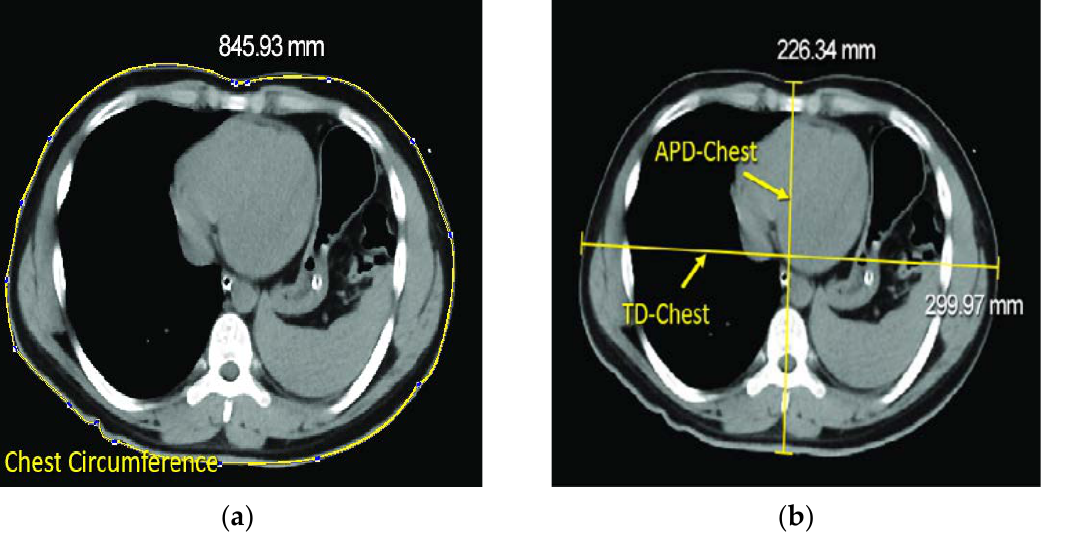
Figure 5. Measuring of the patient’s chest circumference, TD-Chest and APD-chest, performed at the 7th intercoastal space on chest CT. ( a ) Measuring chest circumference by using the built-in meas- uring tool in PACS. ( b ) TD-Chest and APD-Chest, per-formed at the 7th intercoastal space on chest CT.